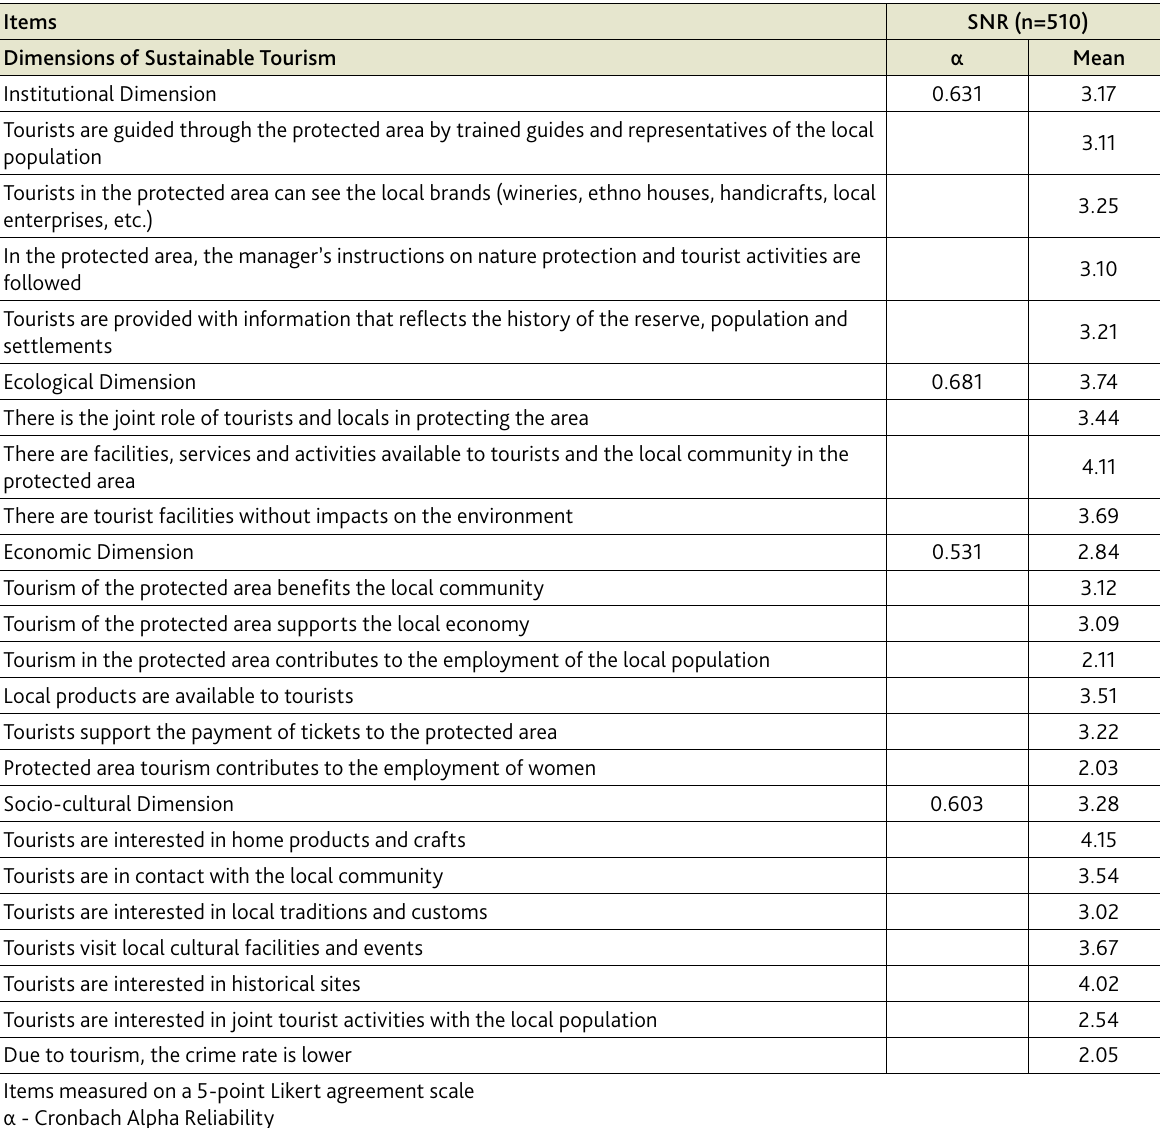
Table 2. Respondents’ perceptions of the dimensions of sustainable tourism Items Dimensions of Sustainable